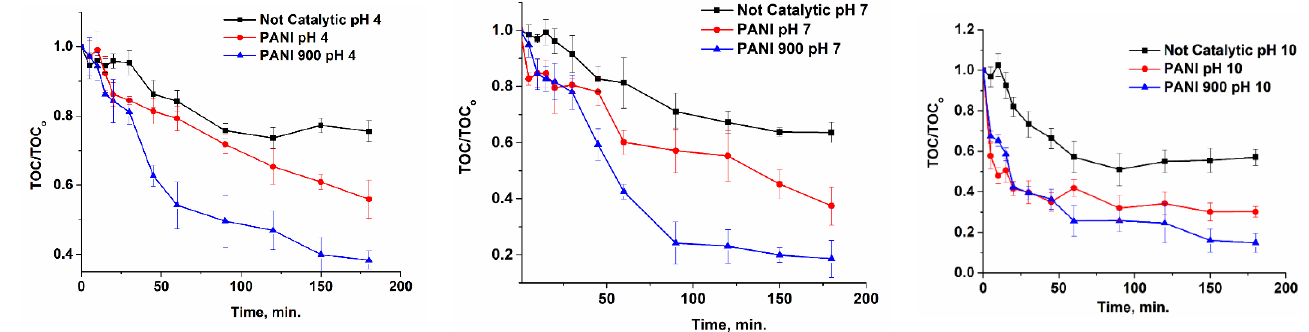
Figure 12. Evolution of normalized TOC for catalytic and non-catalytic oxidation processes at different pH values.